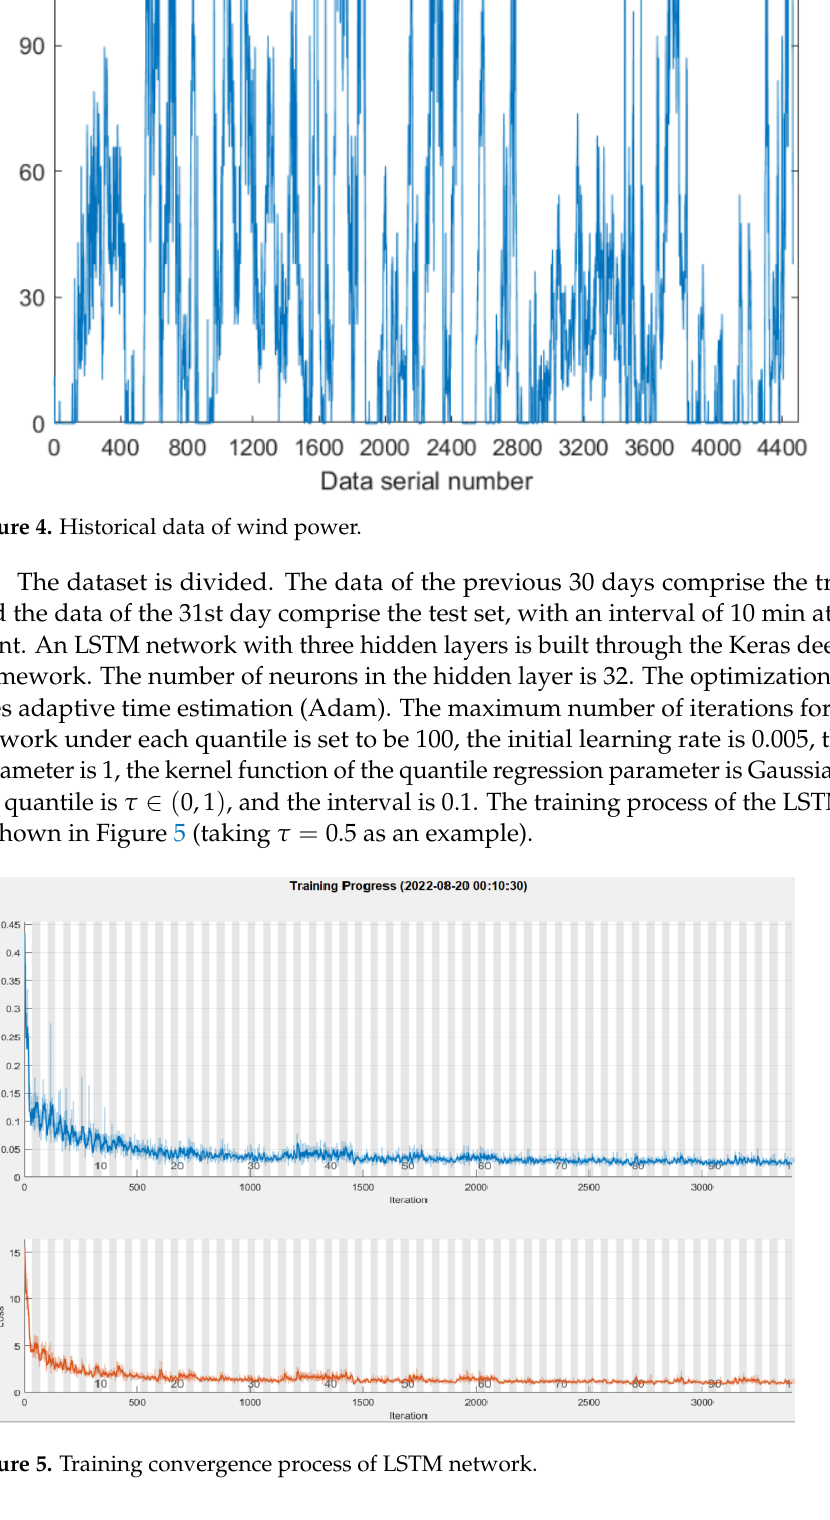
Figure 6. Forecast results of wind power interval at 36 time points in the future.